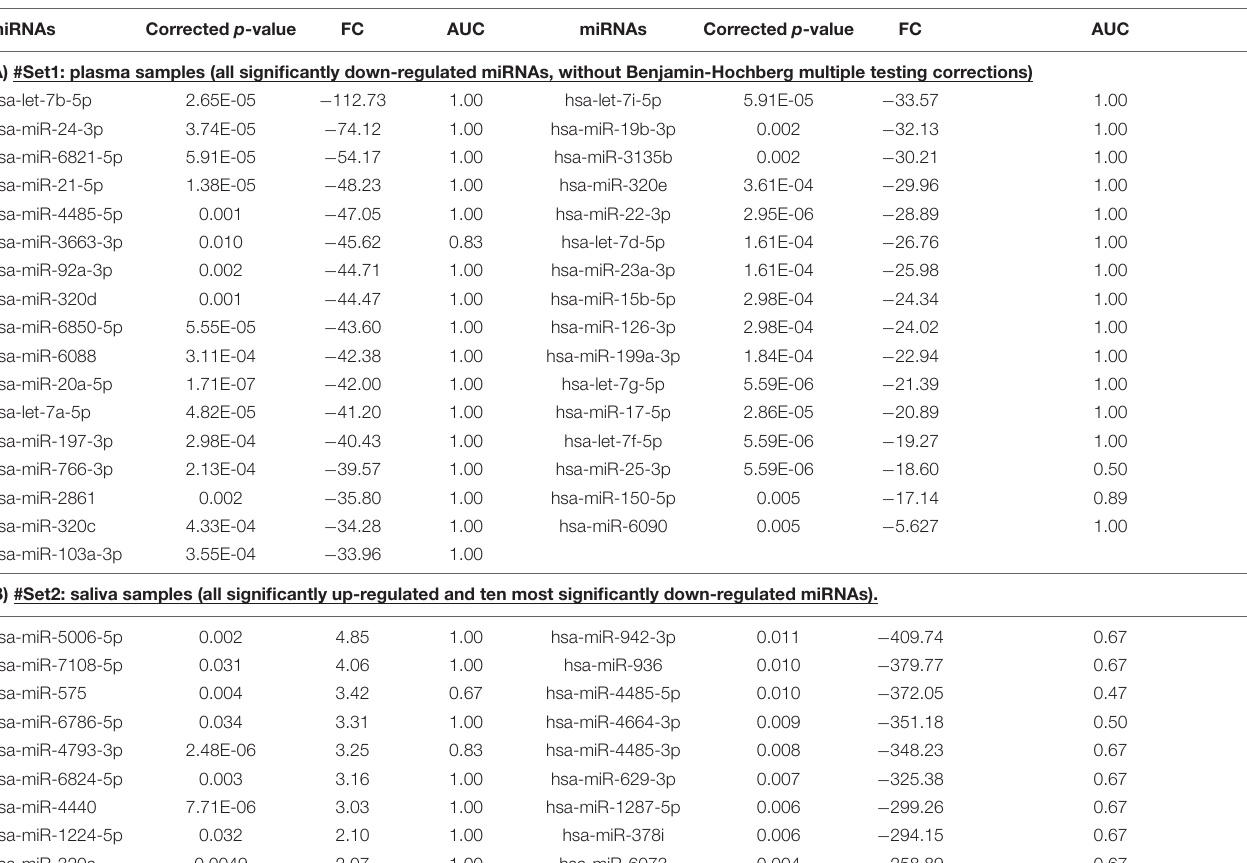
TABLE 2 | P -value, fold change (FC) and area under curve (AUC) of miRNAs in CP exosomal samples as compared to healthy exosomal samples are tabulated as below. miRNAs Corrected p -value FC AUC miRNAs Corrected p -value FC